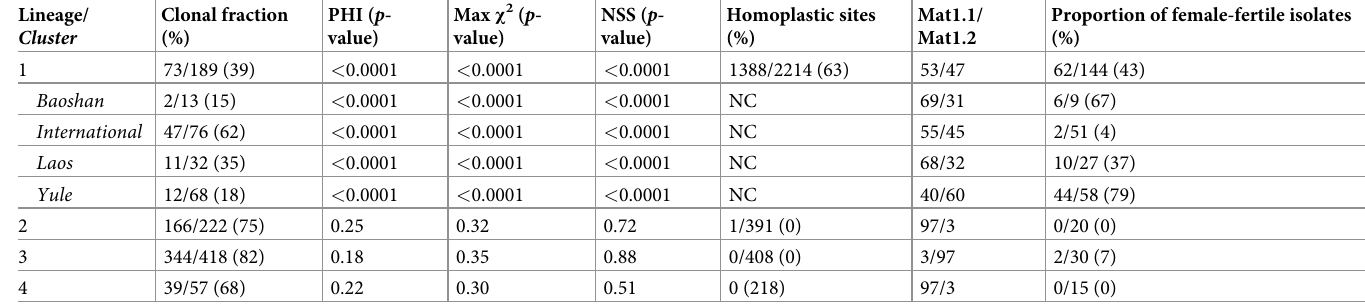
Table 1. Tests for recombination (null hypothesis: clonality), clonal fraction ((sample size N—number of genotypes G)/sample size N), distribution of mating types Mat1.1/Mat1.2, proportion of females fertile isolates, and proportion of homoplastic polymorphisms. Analyses were conducted for four lineages, and for clusters within lineage